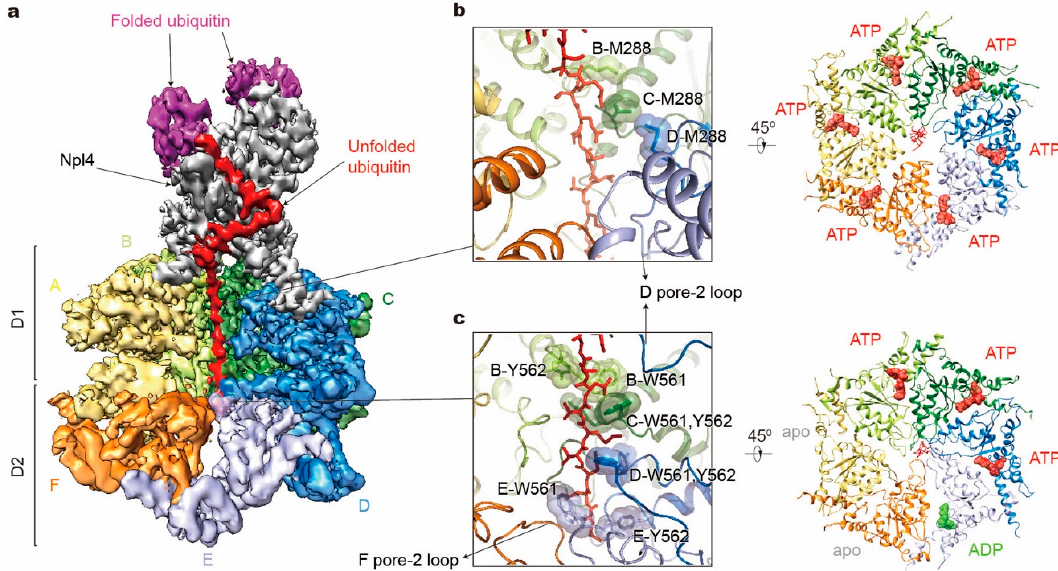
Figure 5. Structure illustration of the tandem hexameric ATPases of Cdc48 processing a substrate. ( a ) Cryo-EM density map of the Cdc48– Ufd1-Npl4 (UN)–substrate complex in the presence of ATP and with Cdc48 carrying a Walker B mutation (EMDB ID: 0665; PDB ID: 6OA9). D1 domains of subunits E and F are both omitted for clarity. Densities of Ufd1 and N domains are too vague to be shown. ( b,c ) Substrate interactions with the Cdc48 D1 pore ( b left) and D2 pore ( c left), and corresponding nucleotide states of six ATPases (right). Only key residues in pore-1 loops are labeled here.